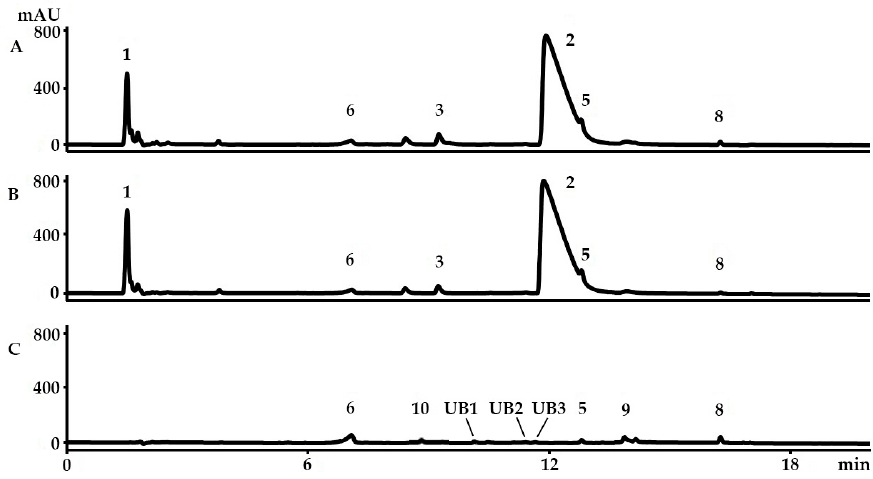
Figure 4. Representative chromatograms of the extracts from the hypobranchial gland of Dicathais orbita from the diode array detector at 210 nm. The solvents used for the extraction of the secondary metabolites are: ( A ) methanol; ( B ) ethanol; and ( C ) chloroform. Numbered peaks are as follows: ( 1 ) murexine, ( 2 ) tyrindoxyl sulphate, ( 3 ) tyrindoxyl S-oxide sulphate, ( 5 ) tyrindoleninone, ( 6 ) 6-bromoisatin, ( 8 ) tyriverdin,